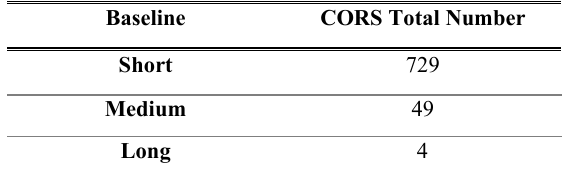
Figure 7 . CORS distribution within the frame using short, medium and long baseline length. The red diamond dots shown in Figure 7 indicate the boundary for the frames, while the black dots indicate the CORS. The blue circle shown indicates as CORS coverage area with baseline length as radius. The space between black dots is defined by the length of input baseline. Table 4 shows total distribution of CORS within the designed frame using the length of short, medium, and long baselines.